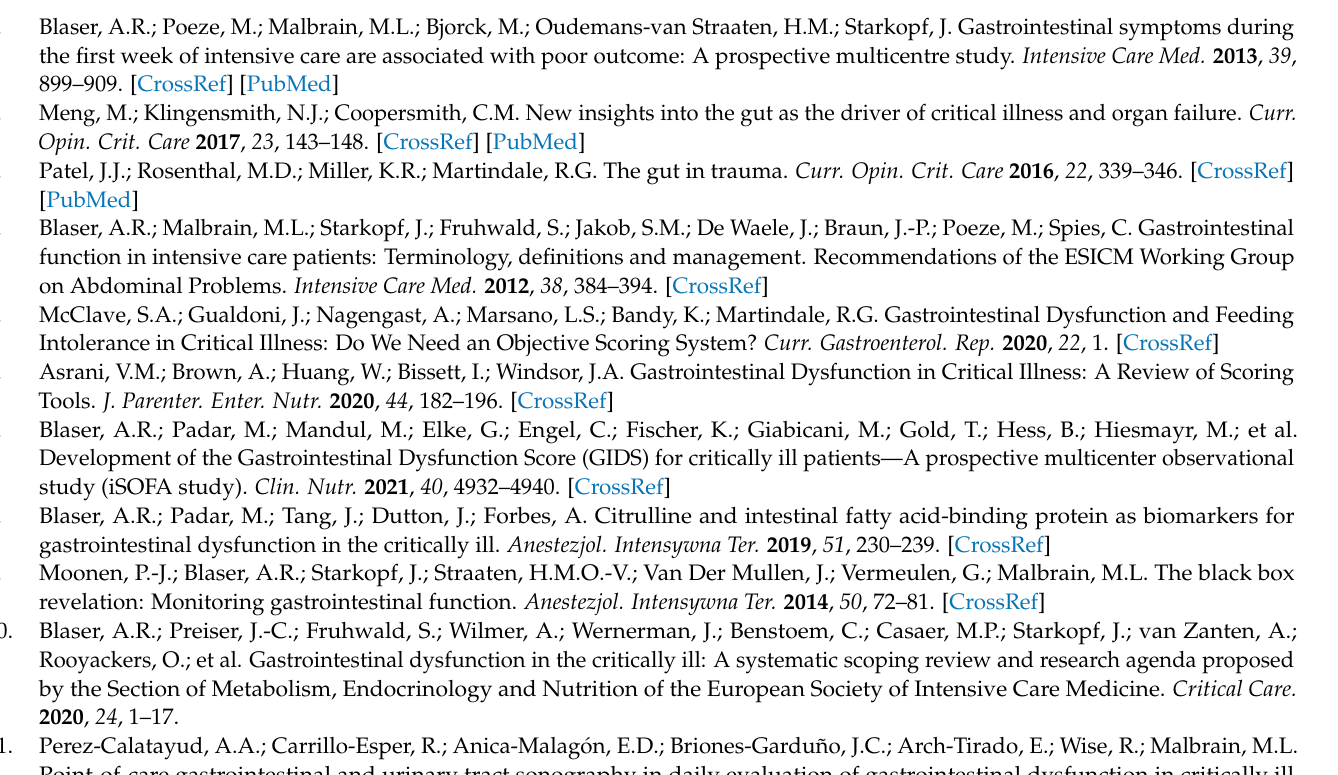
continuous variables. AGI: acute gastrointestinal injury, ICU: Intensive care unit. *: p -value < 0.05; Figure S4: Boxplot of the change of ED 50 , ED 85 , ED mean with GIDS and GIF score. The trend test is mainly based on the median ED 50 , ED 85 , and ED mean of each GIDS grade (a–c) or GIF grade (d–f), which were input separately into the linear logistic regression model as continuous variables. GIDS score: Gastrointestinal Dysfunction Score; GIF score: Gastrointestinal Failure score; Table S1: Detailed description of feeding intolerance. FI: feeding intolerance; Figure S5: The receiver operating characteristic curve of ED 50 , ED 85 and ED mean in predicting feeding intolerance at enteral nutrition